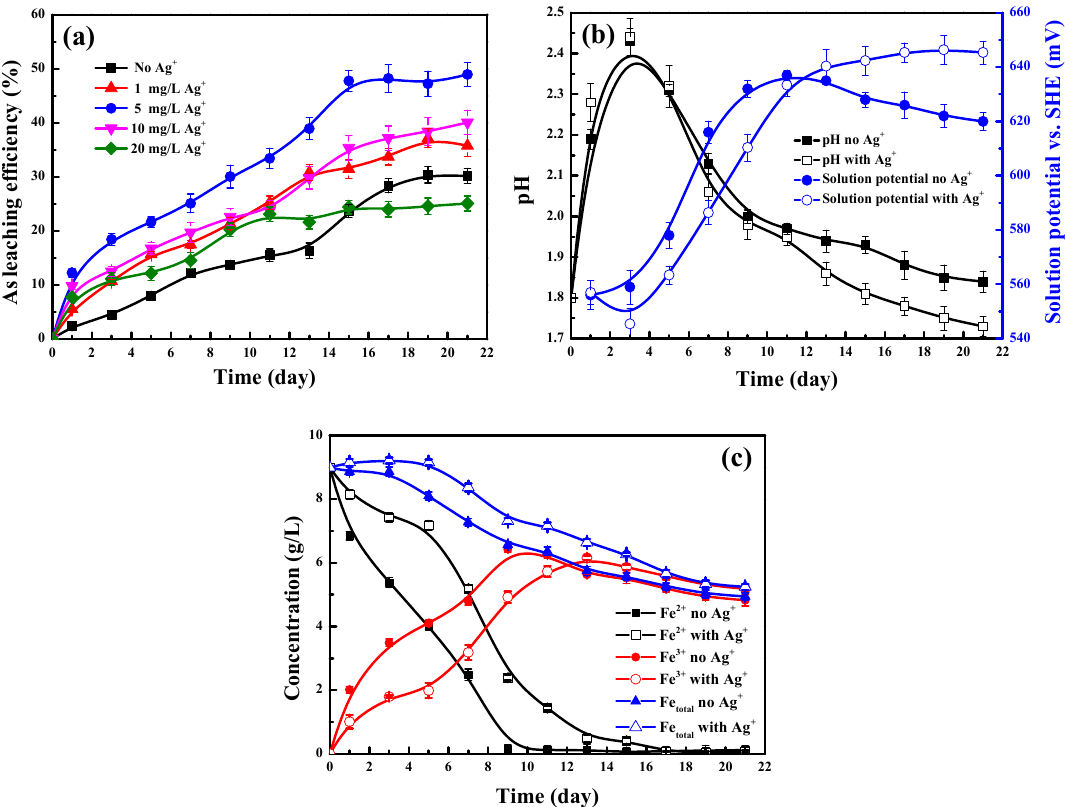
Figure 1. Effect of Ag + concentration on the ( a ) leaching efficiency of As and variation of ( b ) pH and Figure 1. E ff ect of Ag + concentration on the ( a ) leaching e ffi ciency of As and variation of ( b ) pH and solution potential and ( c ) concentrations of Fe 3+ , Fe 2+ and total Fe in the presence and absence of 5 solution potential and ( c ) concentrations of Fe 3 + , Fe 2 + and total Fe in the presence and absence of 5 mg/L Ag + during the bioleaching of arsenopyrite particles. mg / L Ag + during the bioleaching of arsenopyrite